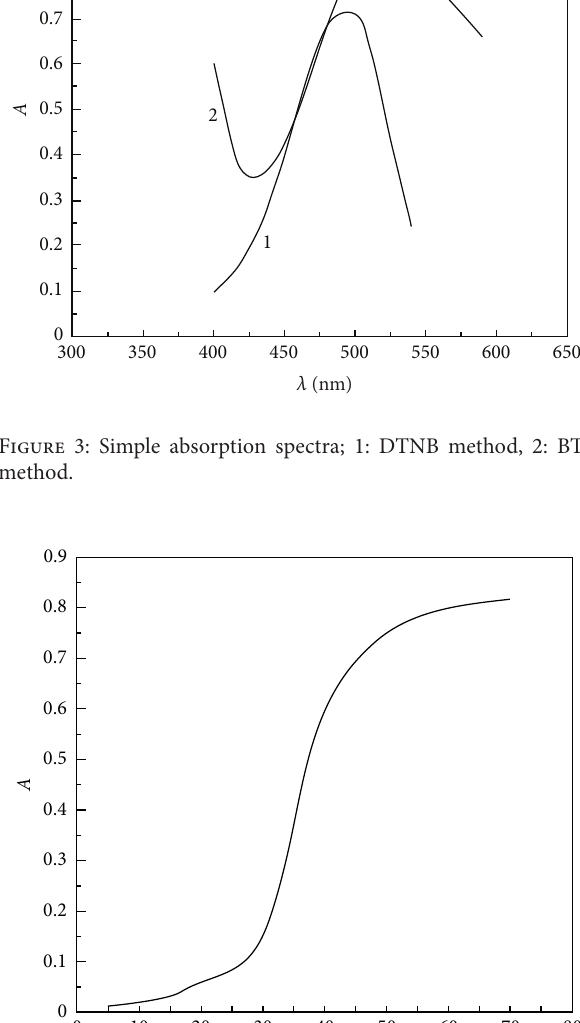
Ratio of molar concentrations NH + F 4: Dependence of absorbance on the ratio of molar con- and reagent. centrations of NH 4+